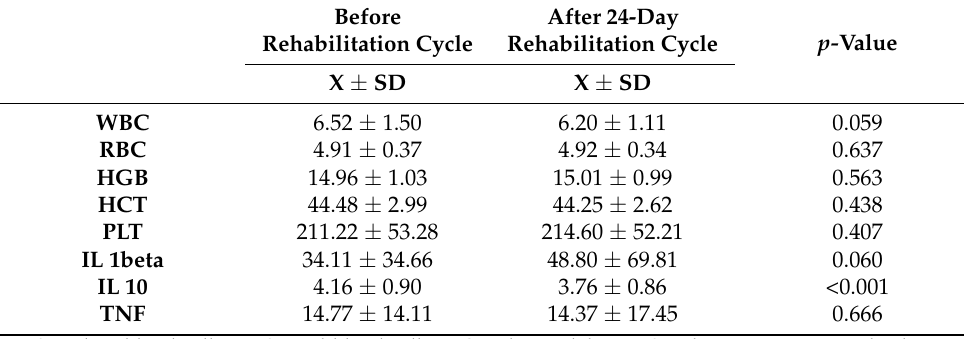
Table 6. Blood morphology.